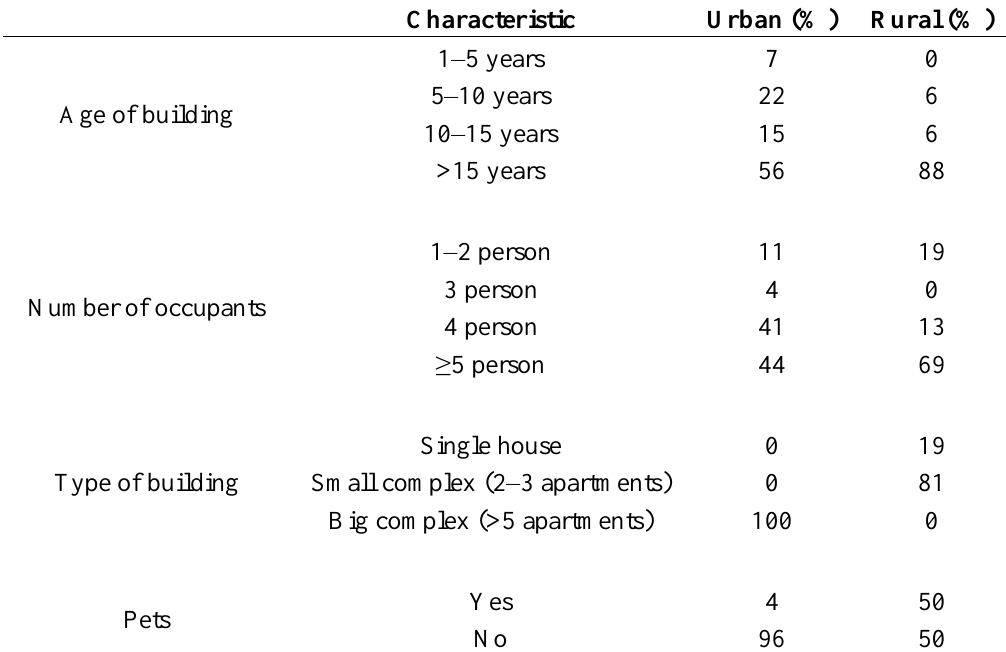
Table 1. Characteristics of the homes under the